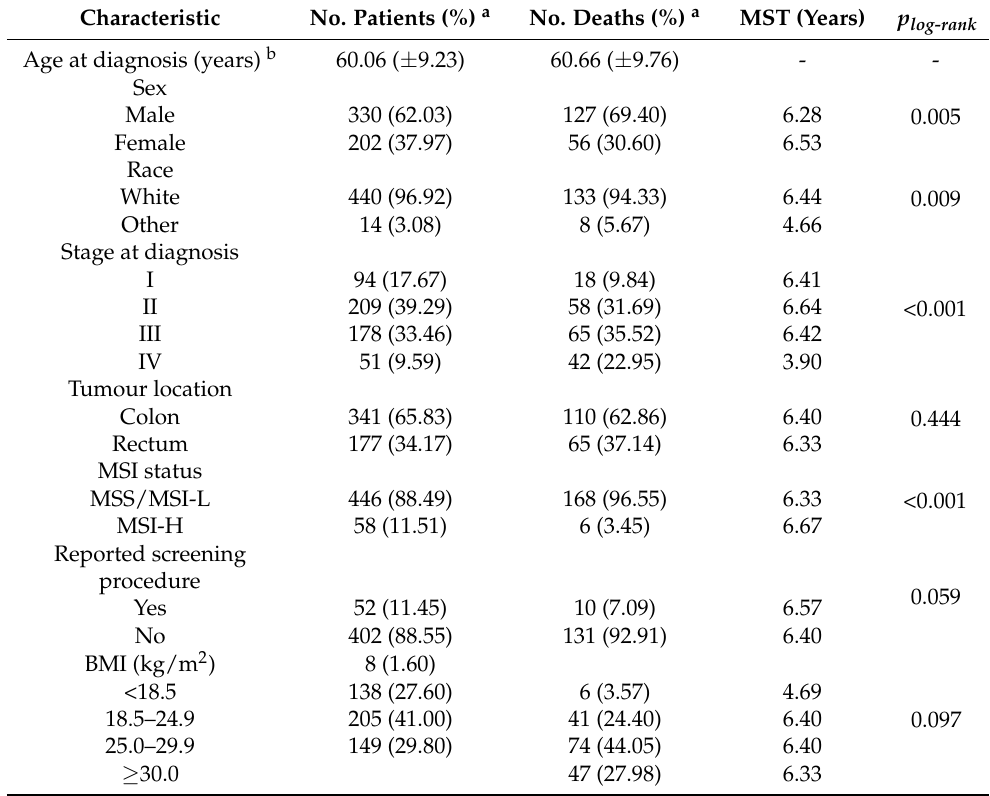
Table 1. Baseline characteristics of patients in the Newfoundland Familial Colorectal Cancer Study